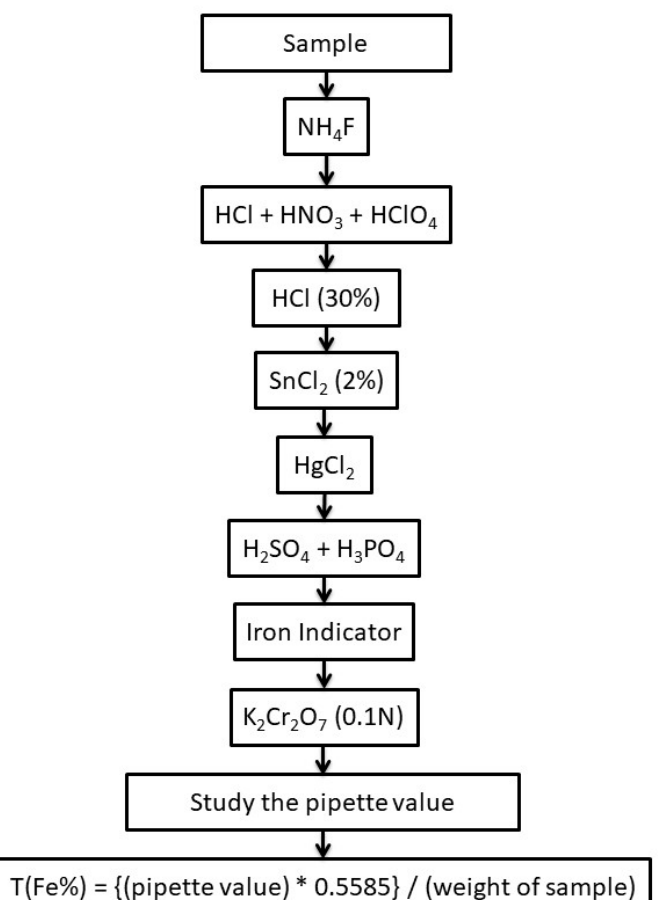
Figure 3. Flowchart for chemical analysis of Fe content.